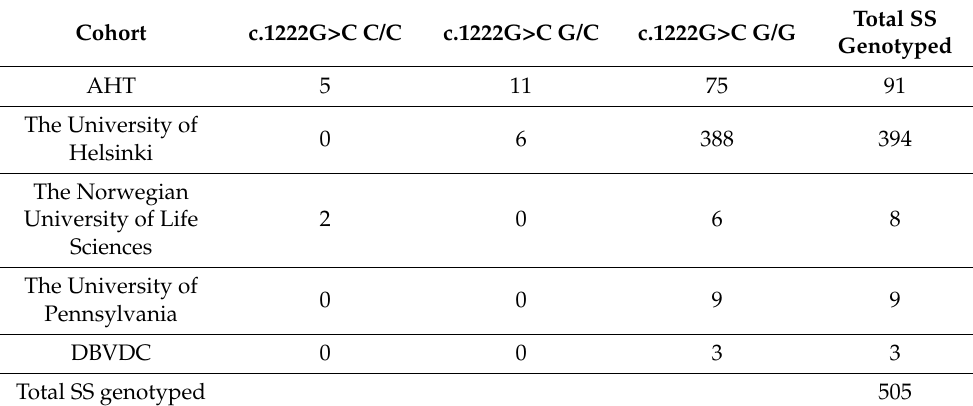
Table 1. Frequencies of the BBS2 c.1222G>C variant in various SS cohorts. ‘G’ represents the wild-type/common allele, ‘C’ represents the alternate allele.